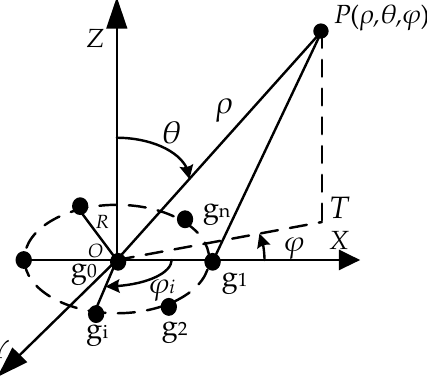
Figure 1. Schematic diagram of the detector.